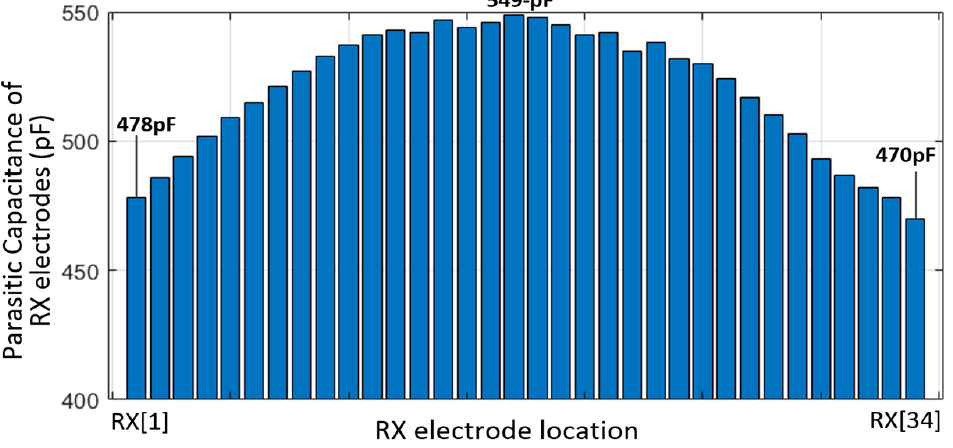
Figure 16. Measured parasitic capacitance of RX electrodes.